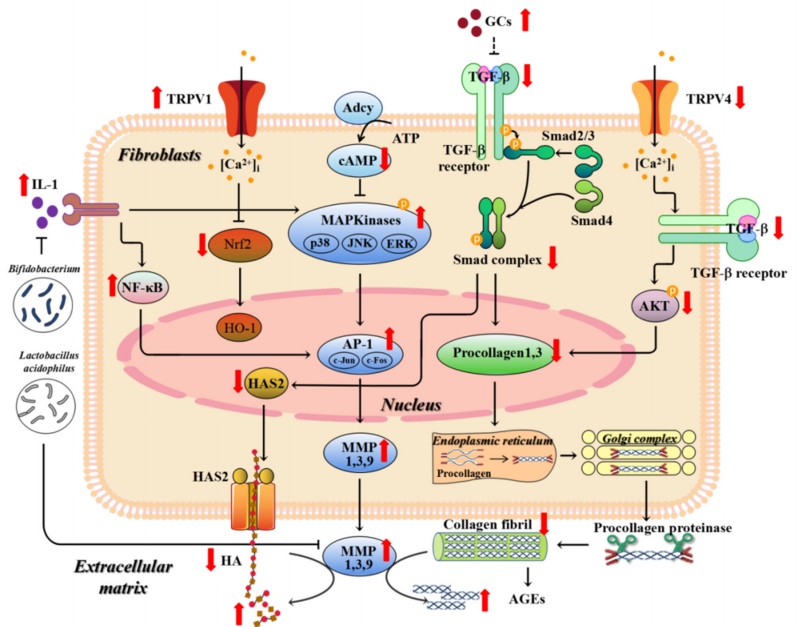
Figure 1. ThemechanismsbywhichUVirradiationregulatescollagenandhyaluronicacidcontentindermal fibroblasts. Adcy: adenylyl cyclase; AGEs: advanced glycation end products; AP-1: activating protein-1; ERK: extracellular signal-regulated kinase; GC: glucocorticoid; HA: hyaluronic acid; HAS2: hyaluronic acid synthase 2; HO-1: heme oxygenase 1; IL: interleukin; JNK: Jun N-terminal kinase; MAPK: mitogen-activated protein kinase; MMP: matrix metalloproteinase; NF- κ B: nuclear factor- κ B; Nrf2: nuclear factor-E2-related factor 2; TGF: transforming growth factor; TRPV: transient receptor potential cation channel